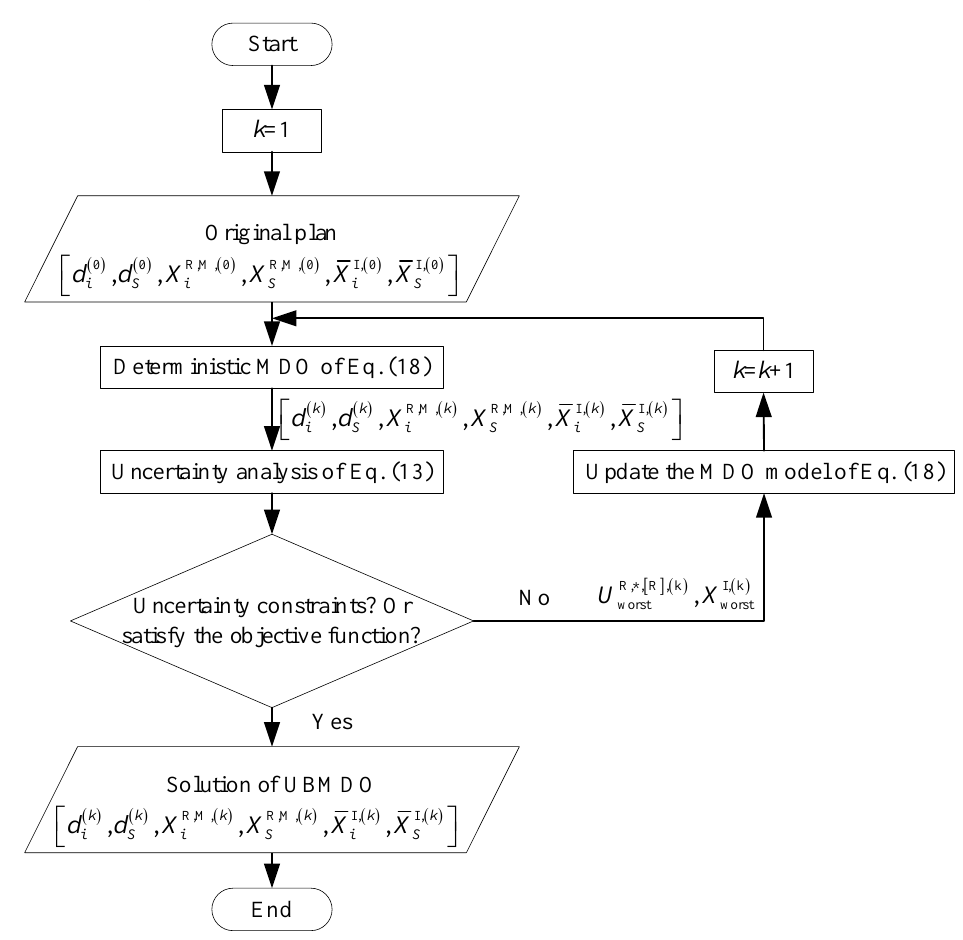
Figure 5. MDO solution flow chart for mixed aleatory and interval uncertainties.